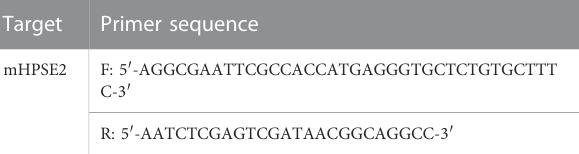
Table 2 according to the manufacturer ’ s recommendations.